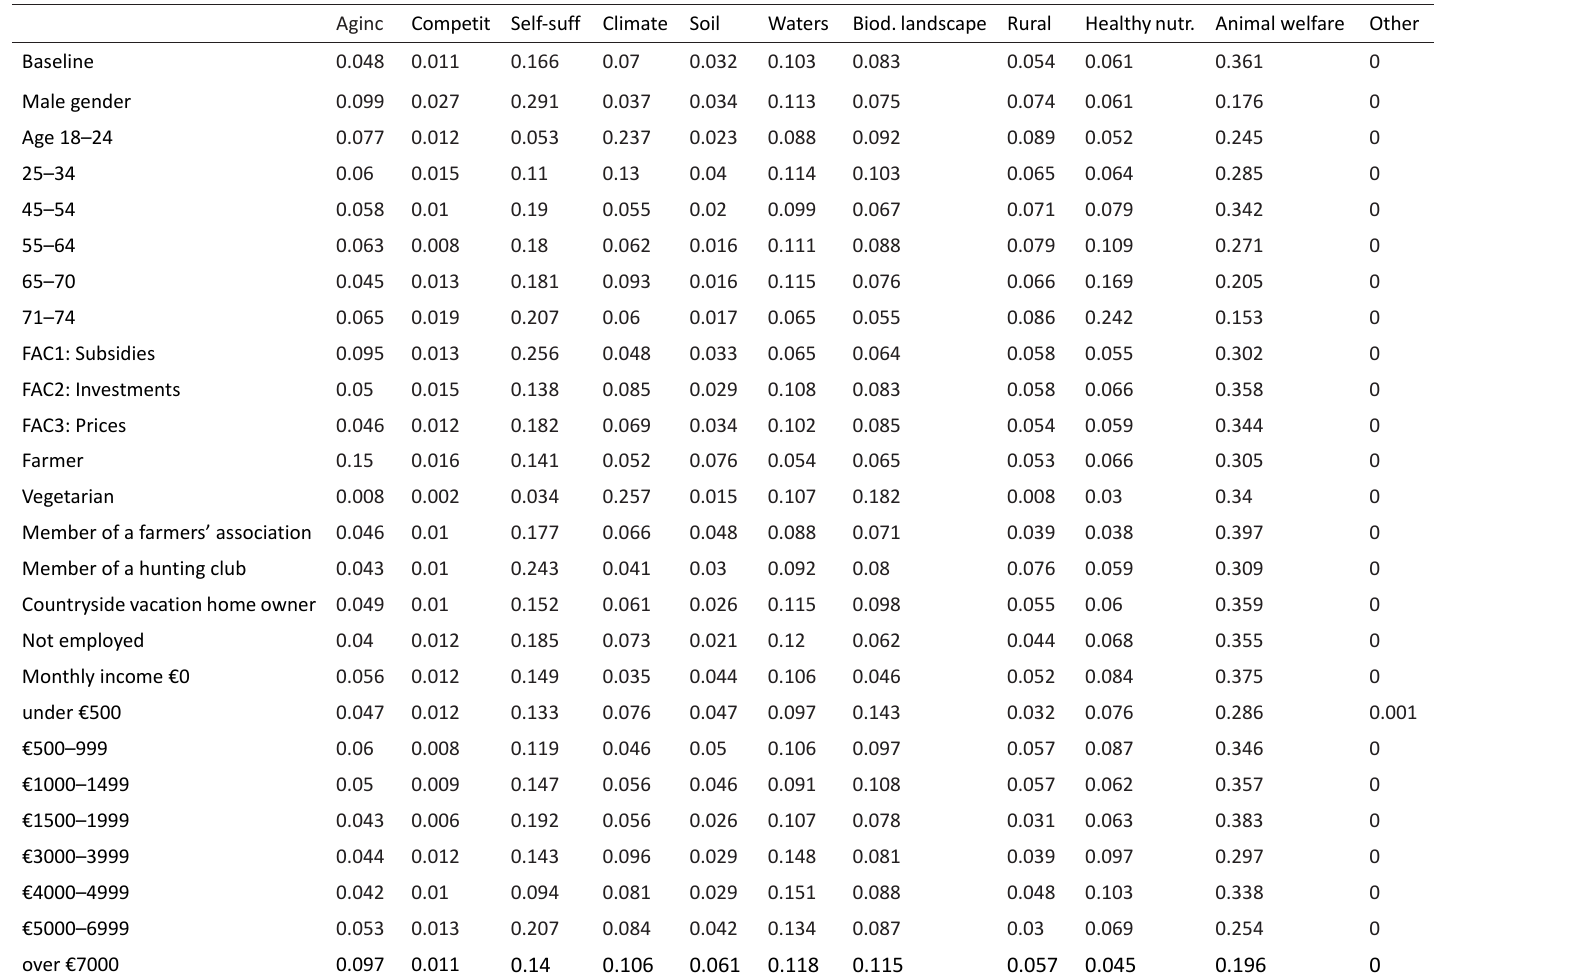
Table 3. Median compositions according to model variables predicted with the compositional regression model. The baseline row represents female respondents in the age class 35–44 years who are non-vegetarian, non-farmers, are not members of relevant organizations and own no vacation home in the countryside, are employed and in the income class €2000–2999, and for whom Factors 1–3 are 0. R 2 = 0.037. Each row presents median budget allocation based on 500 bootstrap samples if the variable in question changes from the